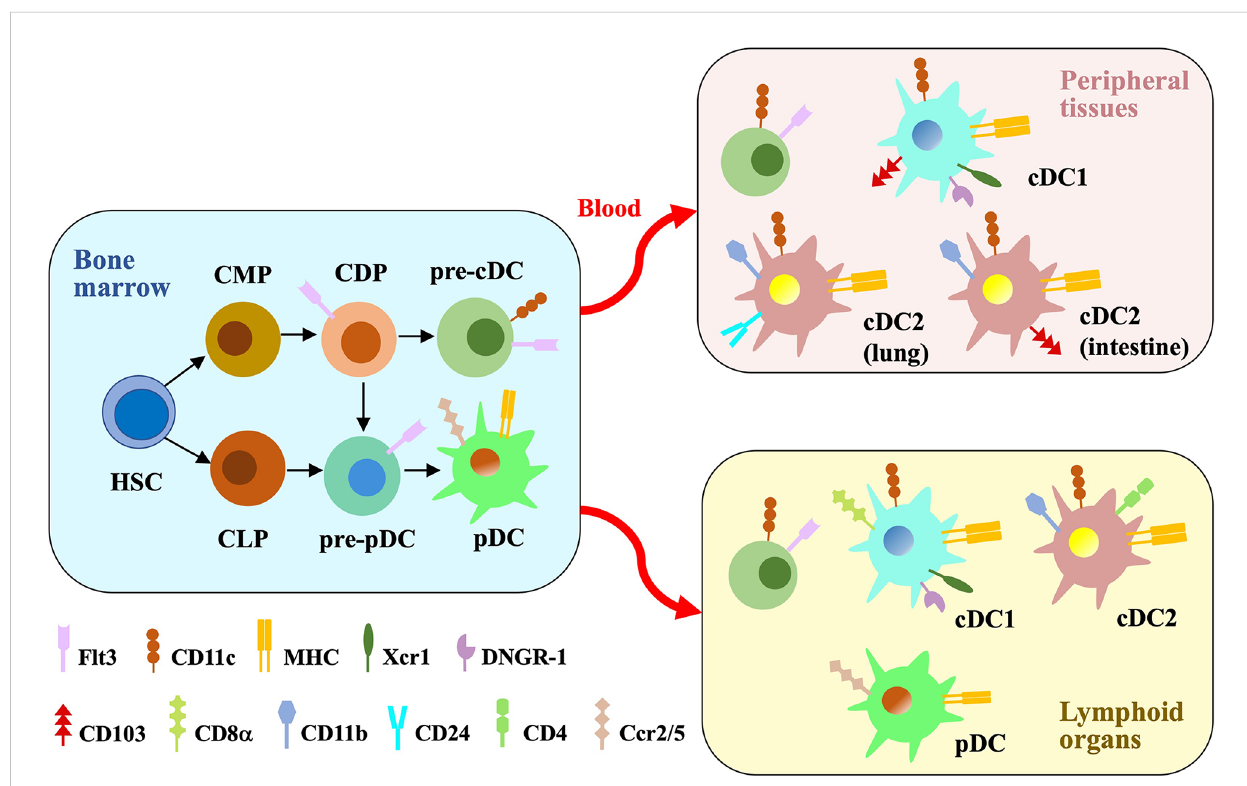
FIGURE 1 Major DC subsets. In the bone marrow, hematopoietic stem cells (HSCs) differentiate into common myeloid progenitors (CMPs) and common lymphoid progenitors (CLPs). CMPs generate DC-fate restricted progenitors called common DC progenitors (CDPs), which are the common progenitors of pre-cDCs and pre-pDCs. Pre-pDCs are also produced from CLPs. Flt3 binding to the ligand induce the differentiation process. Pre- cDCs are released into the blood to reside in peripheral tissues and lymphoid organs, where they differentiate into cDC1s and cDC2s. pDCs get mature in the bone marrow and then migrate to peripheral lymphoid organs through blood. cDCs and pDCs express different cell surface proteins which distinguish their